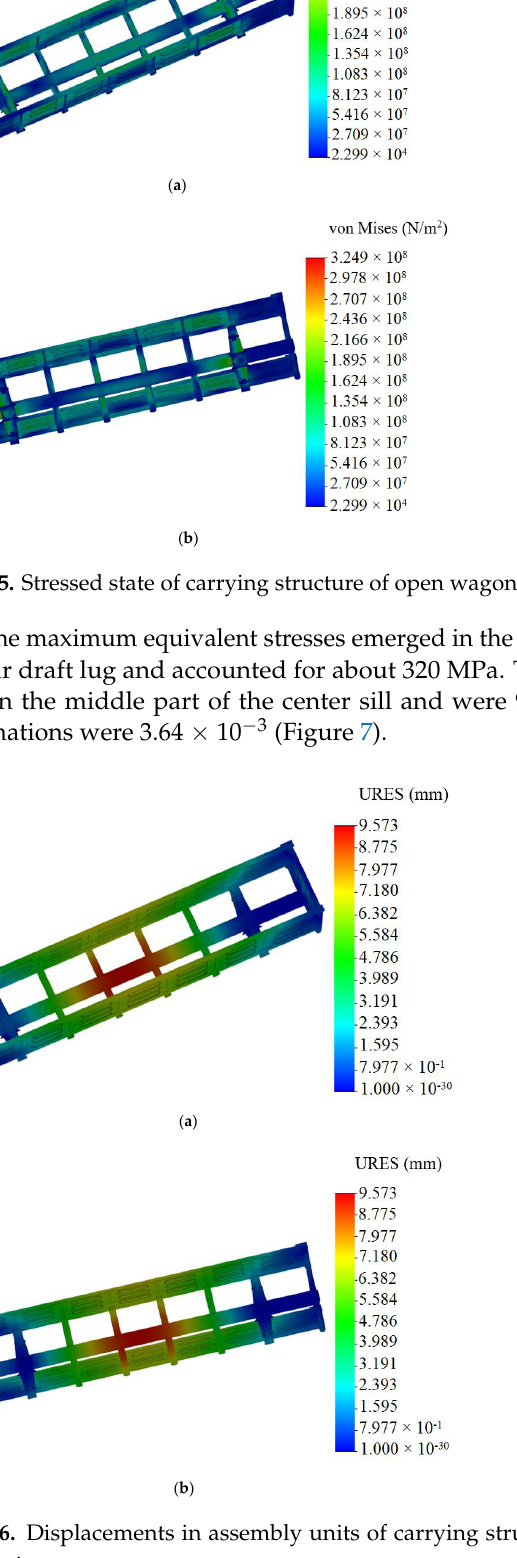
Figure 6. Displacements in assembly units of carrying structure of open wagon ( a ) top view; ( b ) bottom view.